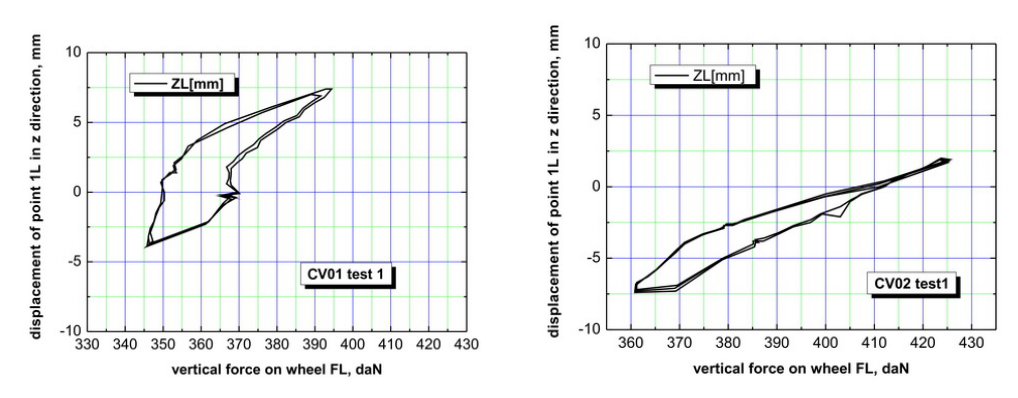
Fig. 5.1. Displacement alterations depending on vertical force during test No. 1.